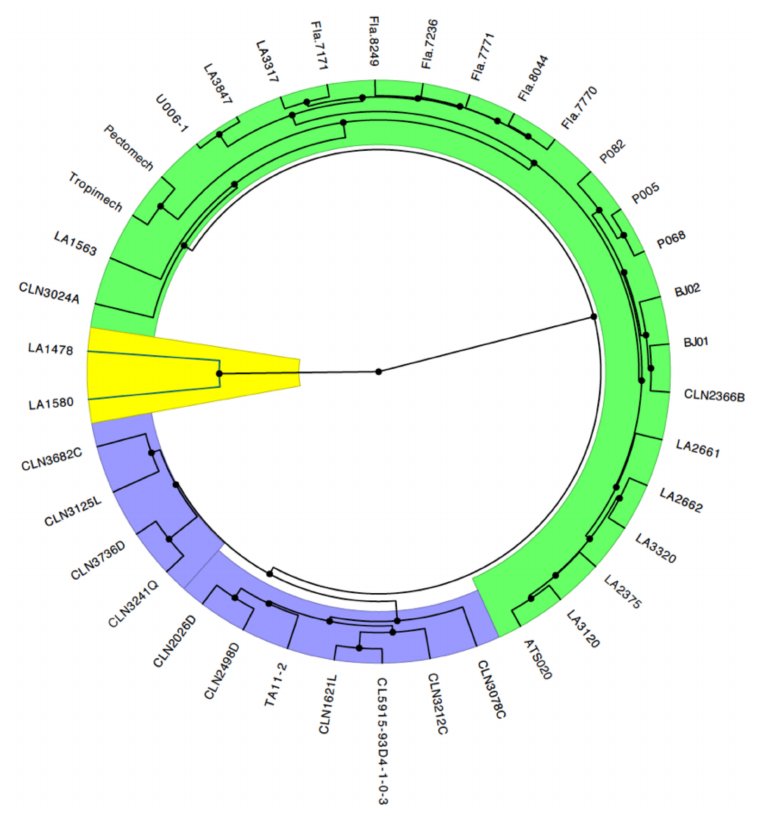
Figure 6. Clustering of the germplasm based on identity by state (IBS) dissimilarity matrix and UPGMA of a tomato germplasm collection. Cluster 1, Cluster 2, and Cluster 3 are highlighted in yellow, purple, and green,